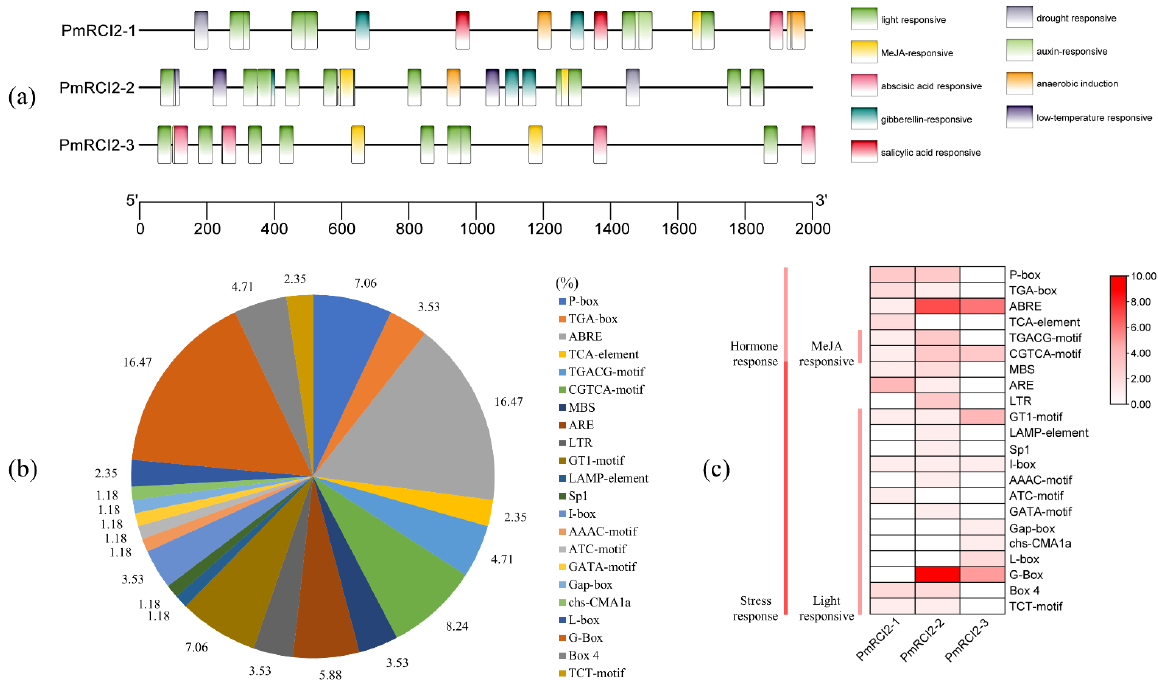
Figure 3. Cis-elements analysis of PmRCI2 s promoters. ( a ) The distribution of the main cis-elements on promoter of identified PmRCI2 s gene. ( b ) The proportion (%) of cis-elements in the PmRCI2 s promoters involved in stress and hormone responses. ( c ) Heatmap of the cis-elements involved in stress responsiveness, and hormone responsiveness.